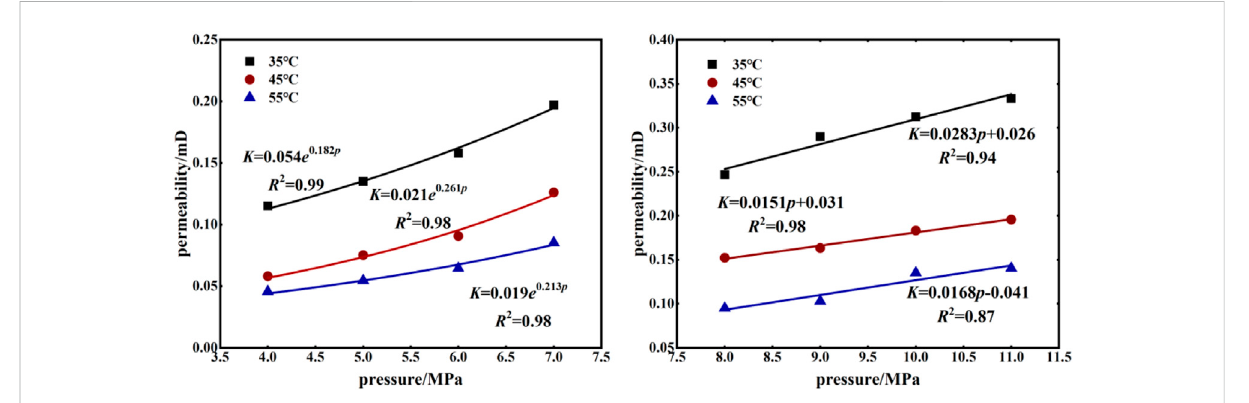
FIGURE 4 Change curves of permeability with an injection of CO 2 and SC-CO 2 pressure.